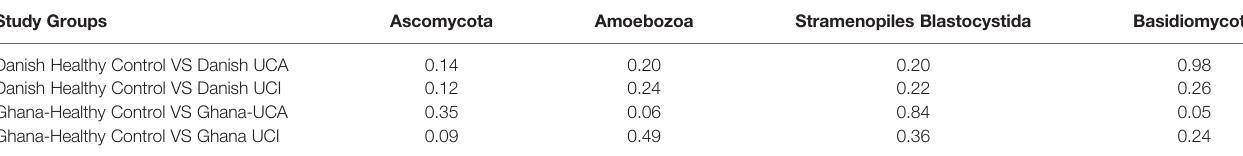
TABLE 3 | P-value for t-test for signi fi cant differences between Eukaryota abundance of the 2 selected study groups.